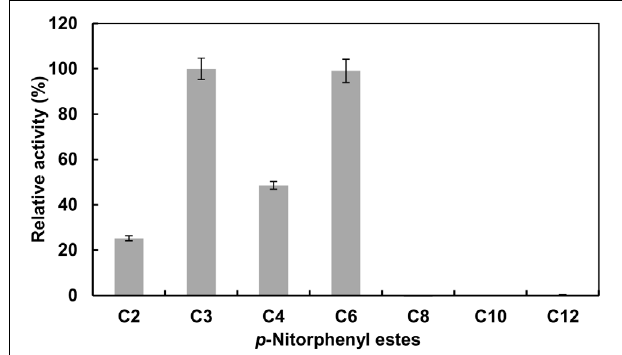
FIGURE 2 | Substrate specificity of EstCS1 toward various p -nitrophenyl esters. Substrates used were p -nitrophenyl acetate (C2), p -nitrophenyl propionate (C3), p -nitrophenyl butyrate (C4), p -nitrophenyl caproate (C6), p -nitrophenyl caprylate (C8), p -nitrophenyl caprate (C10), and p -nitrophenyl laurate (C12). The error bars represent mean ± SD ( n = 3).